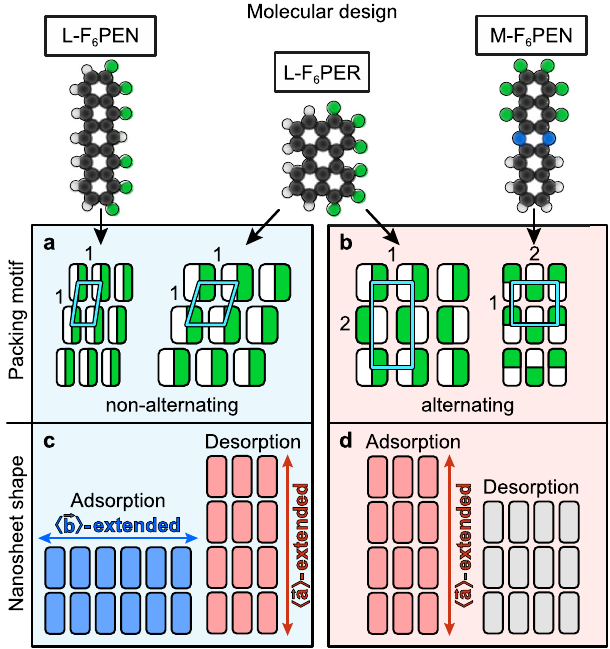
Fig. 4 | Summary of the observed nanosheet shapes and packing motifs. a , b StablepackingmotifsofL-F 6 PEN,L-F 6 PER,andM-F 6 PENwithunitcellsmarked inlightblue.Intheillustrationsofthepackingmotifs,thepredominantlyhydrogen- terminated sides of molecules are coloured white and the predominantly fl uorine terminated halves are coloured green. The carbon backbones (grey) and nitrogen atoms(blue)arenotshownintheillustrationsofpackingmotifs.Numbersindicate the numbers of molecules in the unit cell along the corresponding unit cell edge. c , d Shape of nanosheets that are formed upon growth and partial desorption for * 〉 -extended nanosheets are coloured blue, 〈 a * 〉 -extended these packing motifs. 〈 b sheets are coloured red and sheets with no distinct extension are coloured